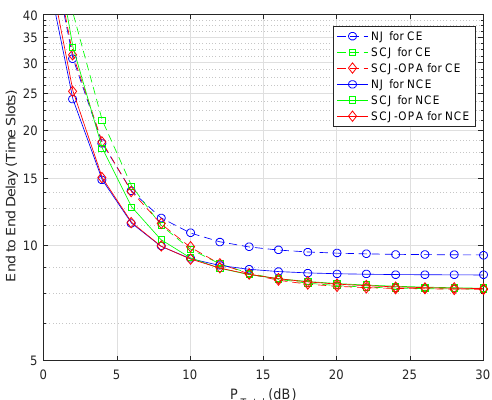
Figure 5. End to end delay vs. the total transmit power budget P Total for the three proposed transmission schemes when R s = 0.6 (bit/s/Hz), M = L = 2, K = 3.